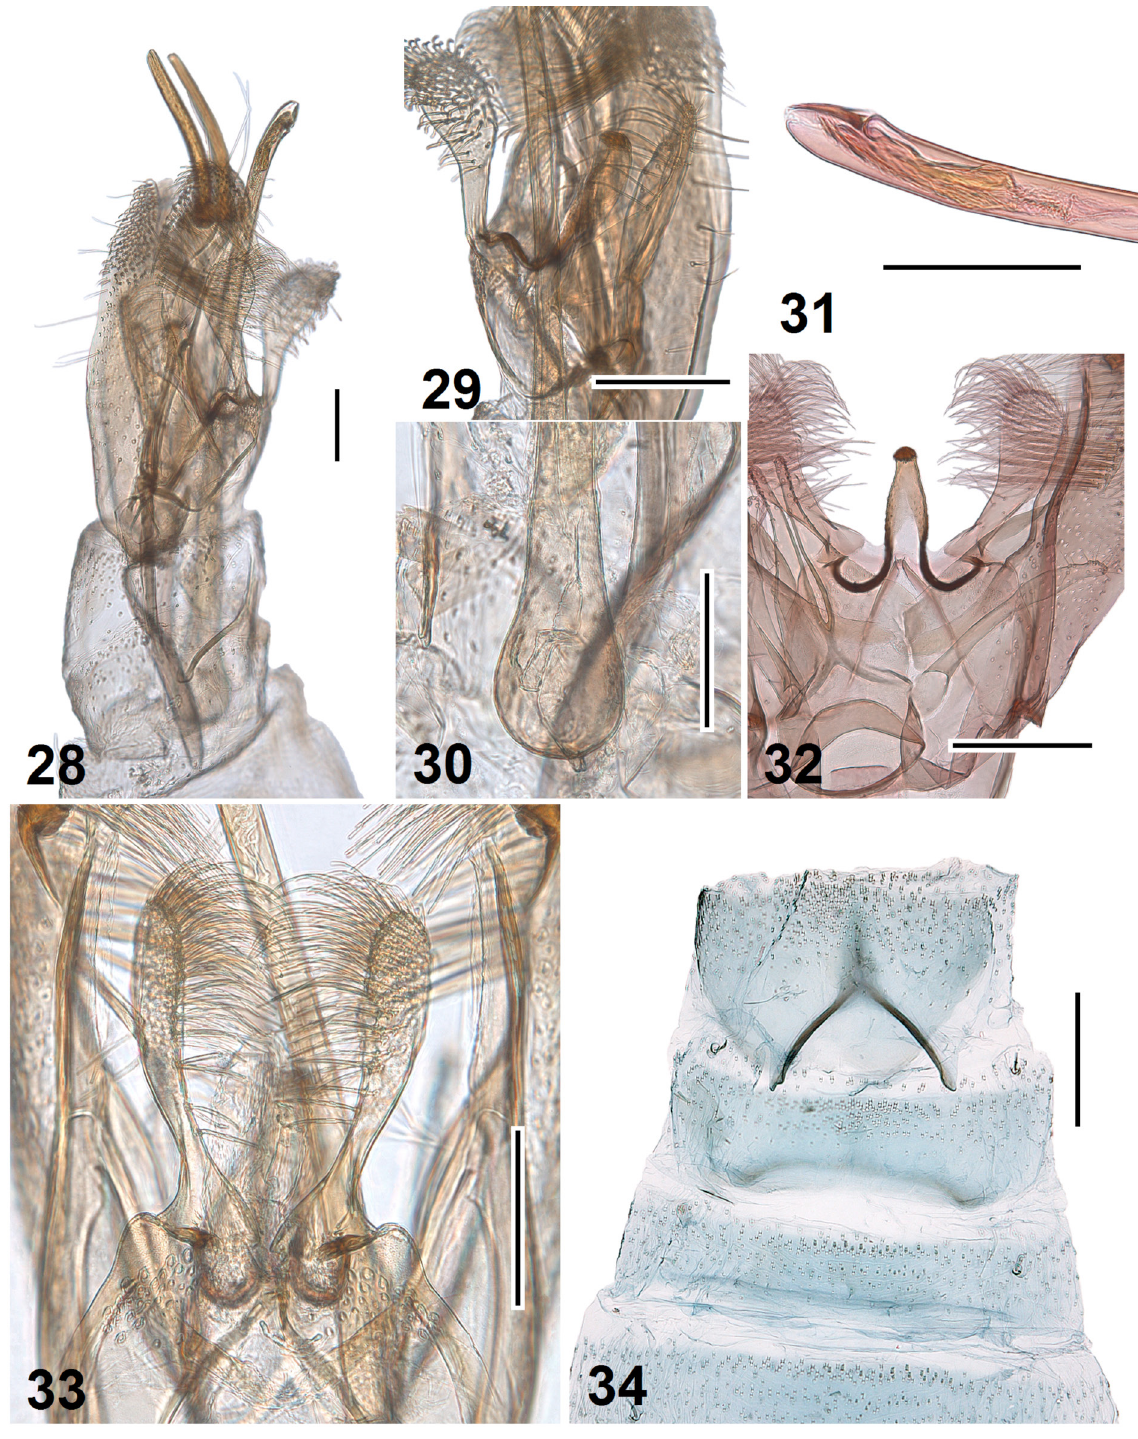
Figs 28–34. Elachista pellineni Sruoga & Kaila sp. nov., male genitalia, holotype, ♂ (MZH VS2/23.11.18, in glycerol before permanent mounting in Euparal). 28 . Lateral view. 29 . Juxta, lateral view. 30 . Proximal part of phallus. 31 . Distal part of phallus. 32 . Juxta region and gnathos. 33 . Uncus lobes, dorsal view. 34 . Distal part of abdomen, dorsal view. Scale bars = 0.1